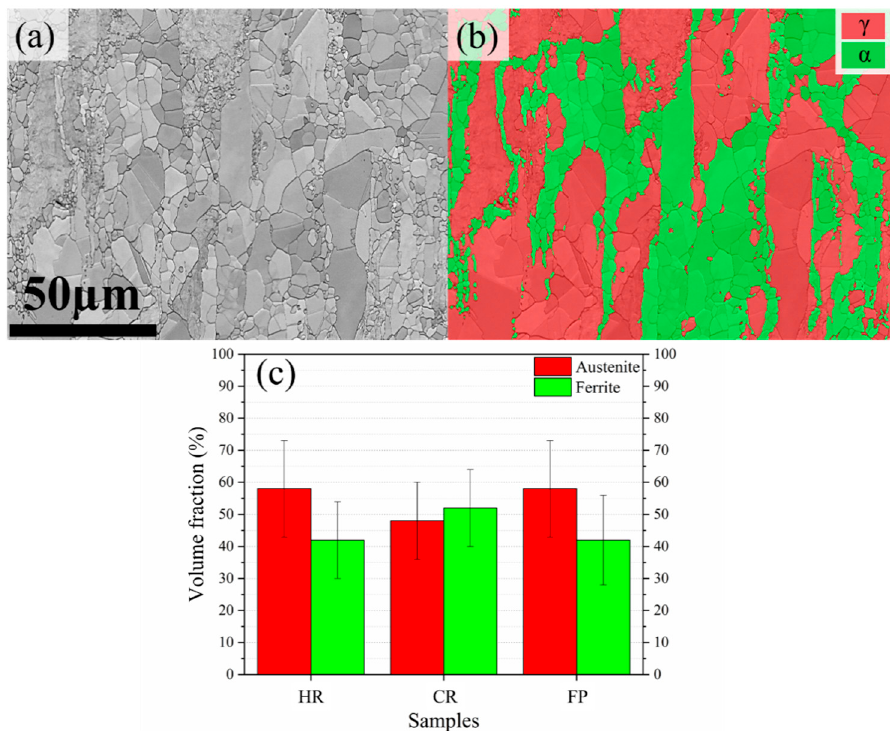
Figure 3. ( a ) Microstructure of the hot rolled (HR) sample illustrated by IQ; ( b ) phase map which illustrates the surface fraction of the γ and α phases; and ( c ) volume fractions of both constitutive phases for all the studied samples.